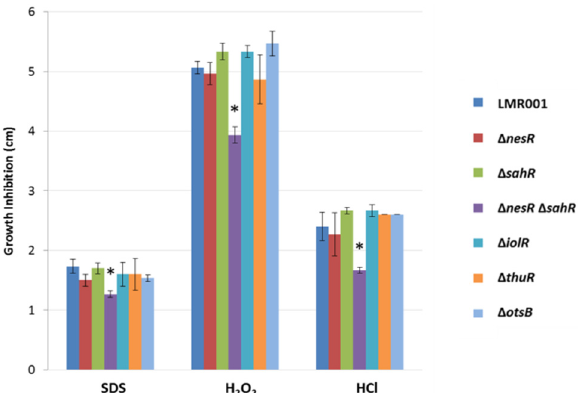
Figure 6. Effects of the mutations on detergent, oxidative and acids stresses. The mean diameters of the growth inhibition zone are shown for the 6 mutants (indicated on the right of the figure). The size of the inhibition zone is inversely correlated to the tolerance as the chemicals (indicted at the bottom of the graph) diffuse away from the disc into the agar (see Materials and Methods). Error bars correspond to standard deviations and significant differences with LMR001 data ( p -value < 0.05, Tukey’s Test) are indicated by “*” above the corresponding bar.